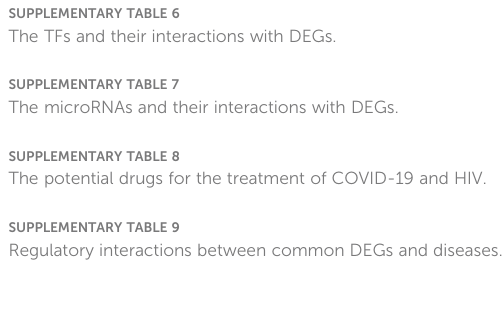
SUPPLEMENTARY TABLE 2 The expression of HIV differentially expressed genes. SUPPLEMENTARY TABLE 3 Volcano plots of COVID-19 differentially expressed genes. SUPPLEMENTARY TABLE 4 Volcano plots of HIV differentially expressed genes. SUPPLEMENTARY TABLE 5 Common DEGs between COVID-19 and HIV.